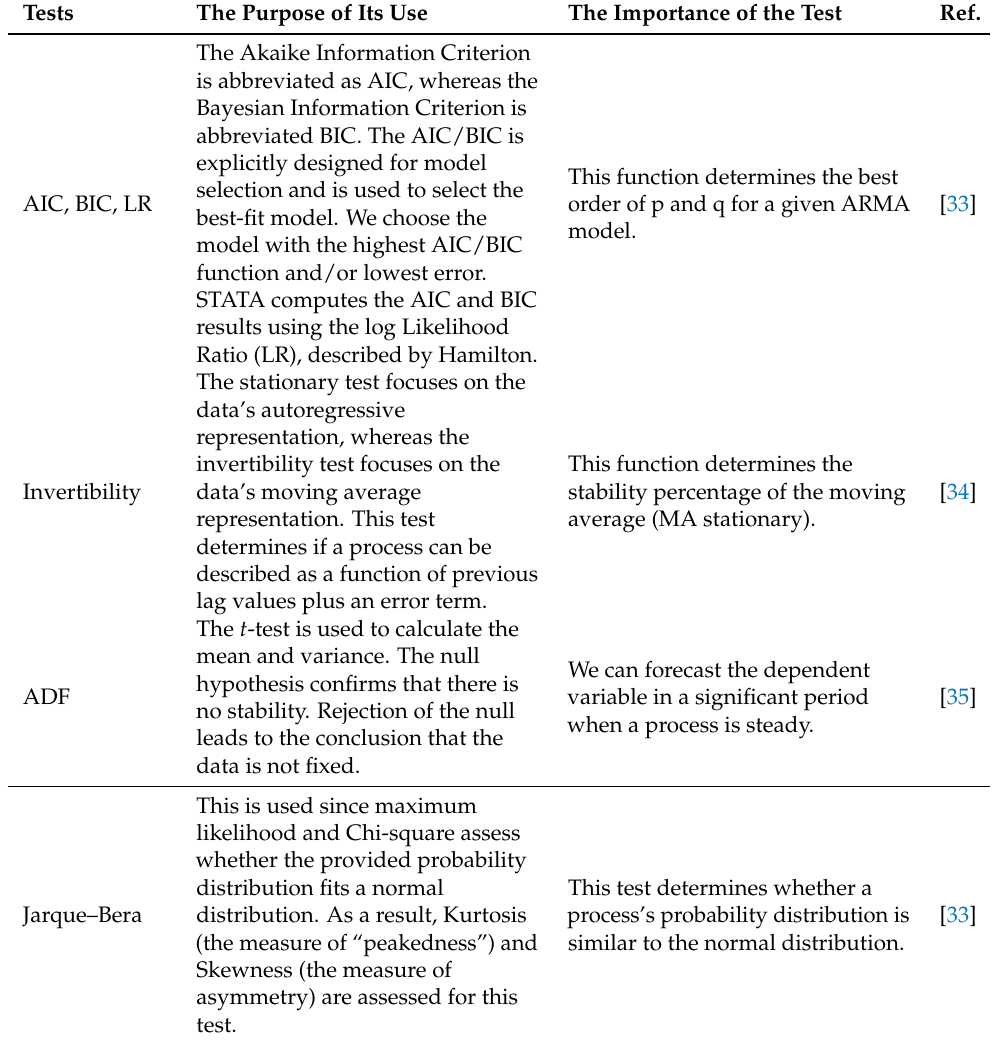
Table 6. Econometric tests and